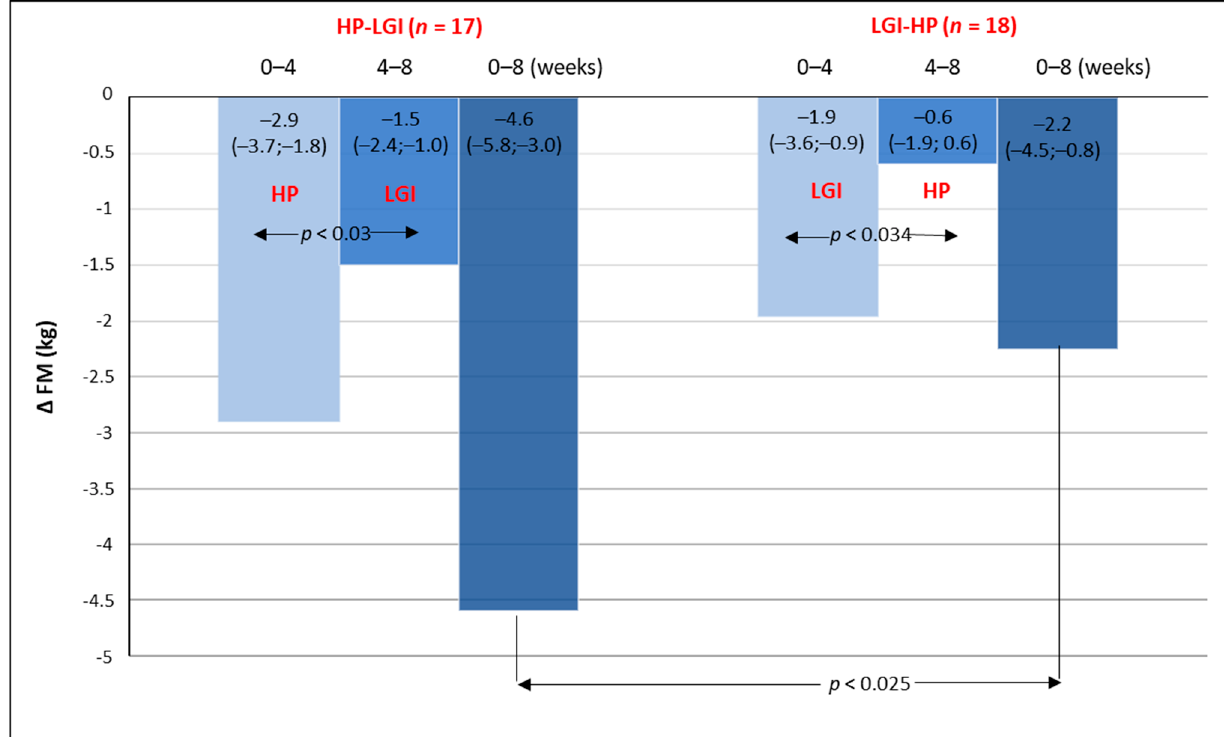
Figure 2. The changes in body mass ( ∆ body mass) during the 8-week period of energy-restricted diets: 4-week high protein (HP) or low glycemic index (LGI) diet given in a random order and followed by the opposite diet.